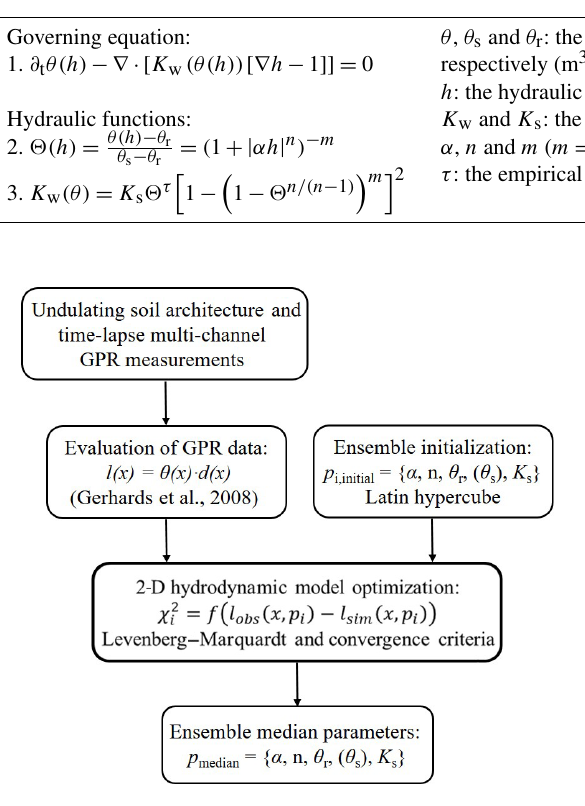
Figure 1. The framework of efficient estimation of effective hy- draulic properties of the surface layer with an undulating interface in a two-layer transect. Provided that the water dynamic range is captured by a small number of time-lapse multi-channel GPR ob- servations, final parameter sets are inversely estimated based on the Levenberg–Marquardt algorithm and proper convergence cri- teria (see Sect. 2). Latin hypercube-sampled initial parameter sets for each ensemble member are used in the 2-D inversion. The final median parameter set is derived from the 68% estimated ensemble parameter sets with minimal χ 2